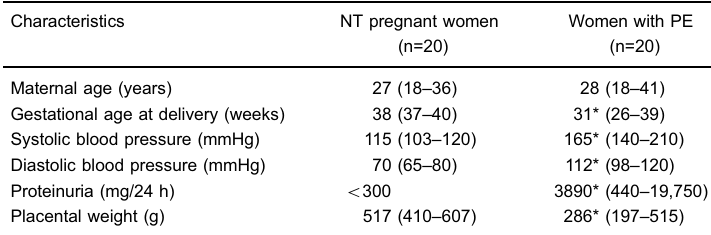
Table 2. Clinical and laboratory characteristics of pregnant women with preeclampsia (PE) and normotensive (NT) pregnant women. Characteristics